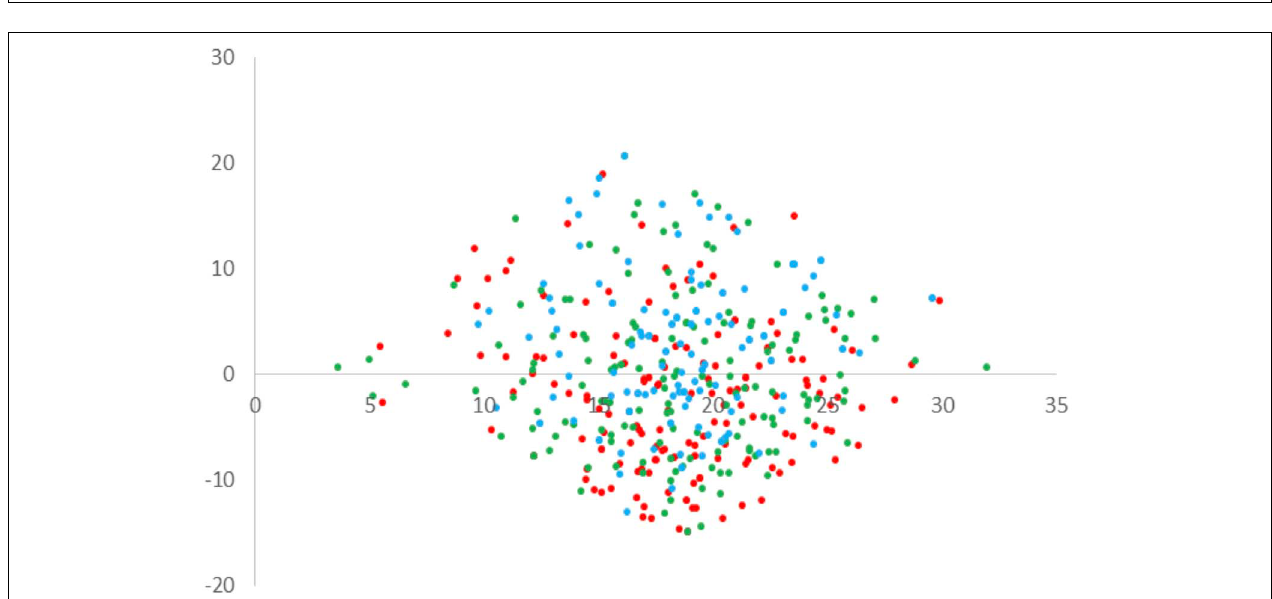
FIGURE 3 | Results of the PCA on emotions of K-8 to K-10 students toward the learning of Physics and Chemistry: loadings plot for PC1 and PC2.